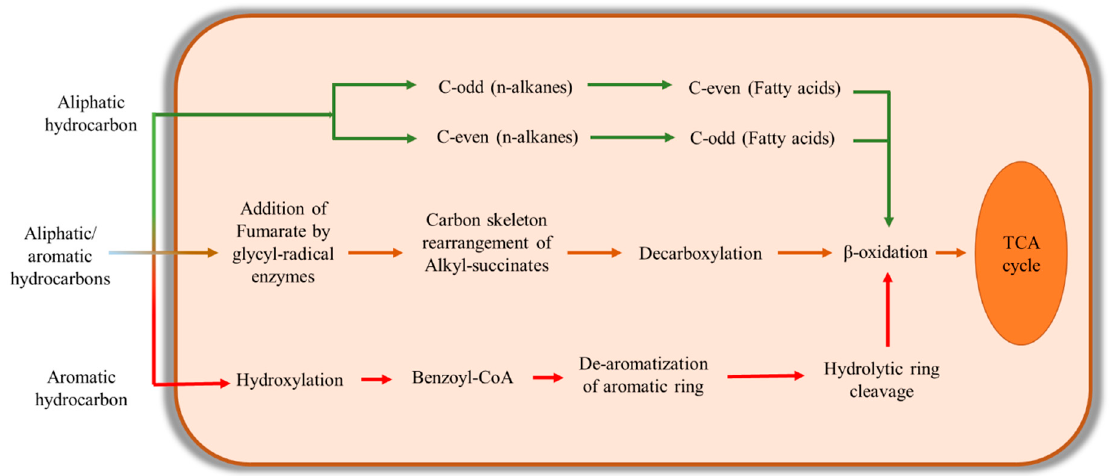
Figure 5. The principle behind anaerobic hydrocarbon degradation by microbes. The arrows represent different degradation reactions [139,141,142].